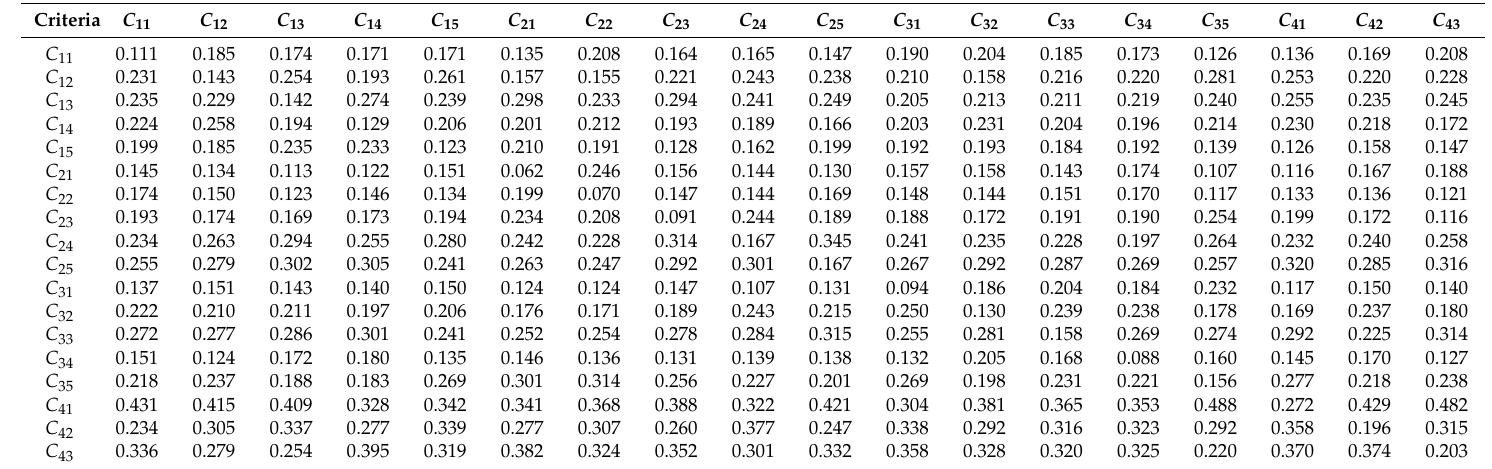
Table A5. The un-weighted supermatrix W α